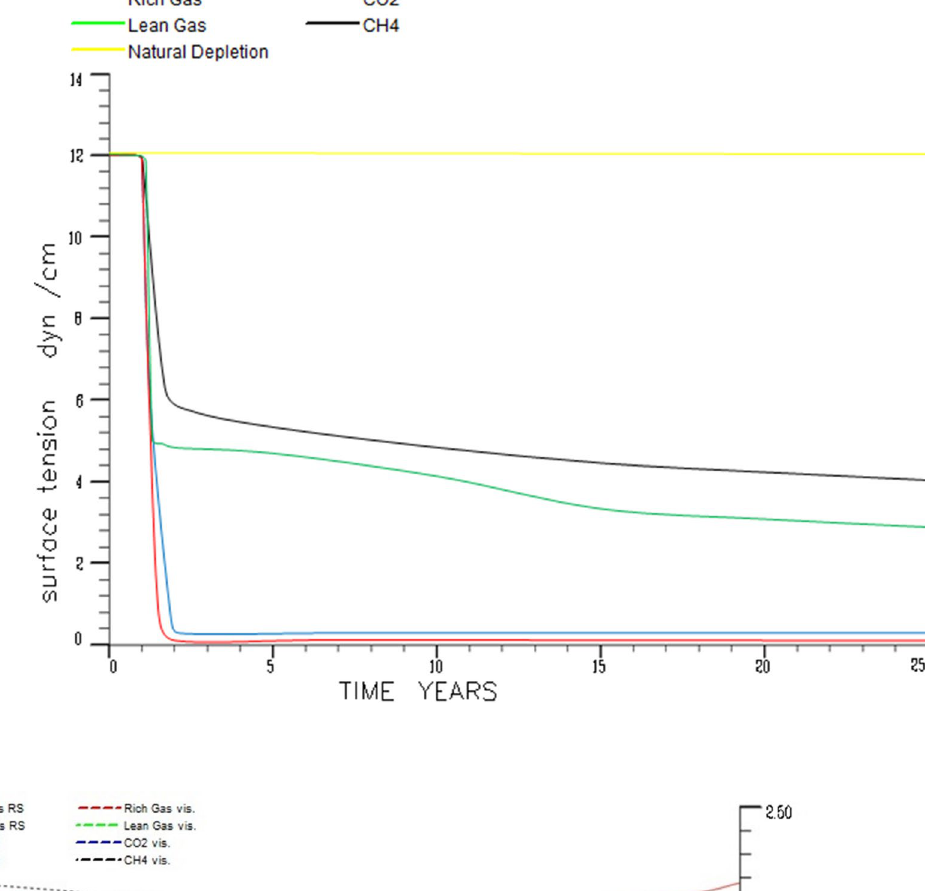
Fig. 7 Surface tension varia- tion in a particular matrix cell